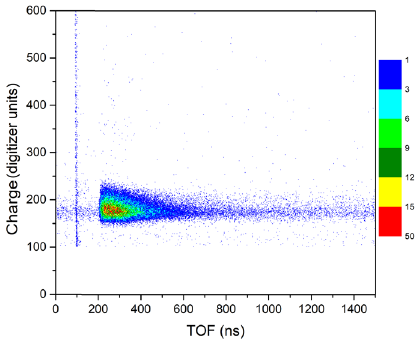
Figure 6. 2D scatter plots of the TOF versus the charge of the detector signals. The γ -rays appear as a vertical line and the neutrons appear in the horizontal band with a drop shape.